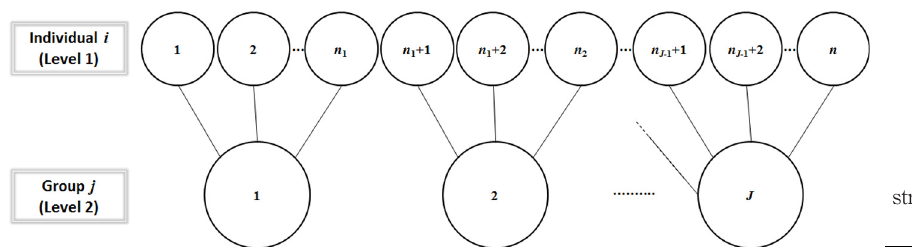
Figure 1. Two-level nested structure of